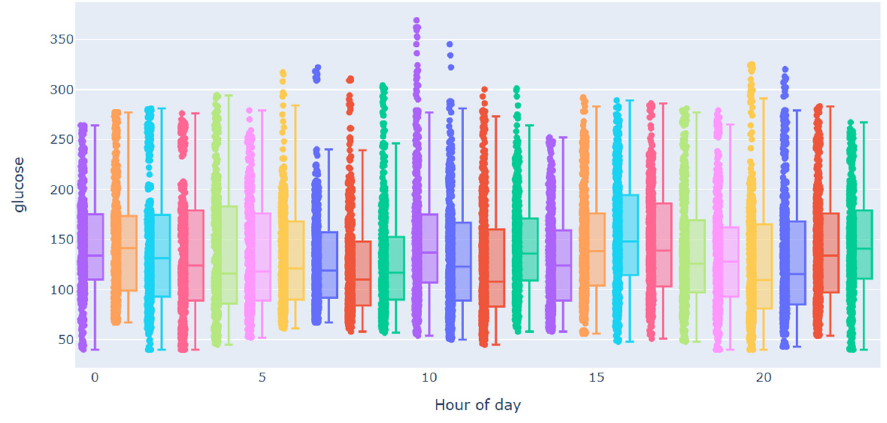
Figure 4. Boxplots of CGM by hour of the day for the training data of the subject